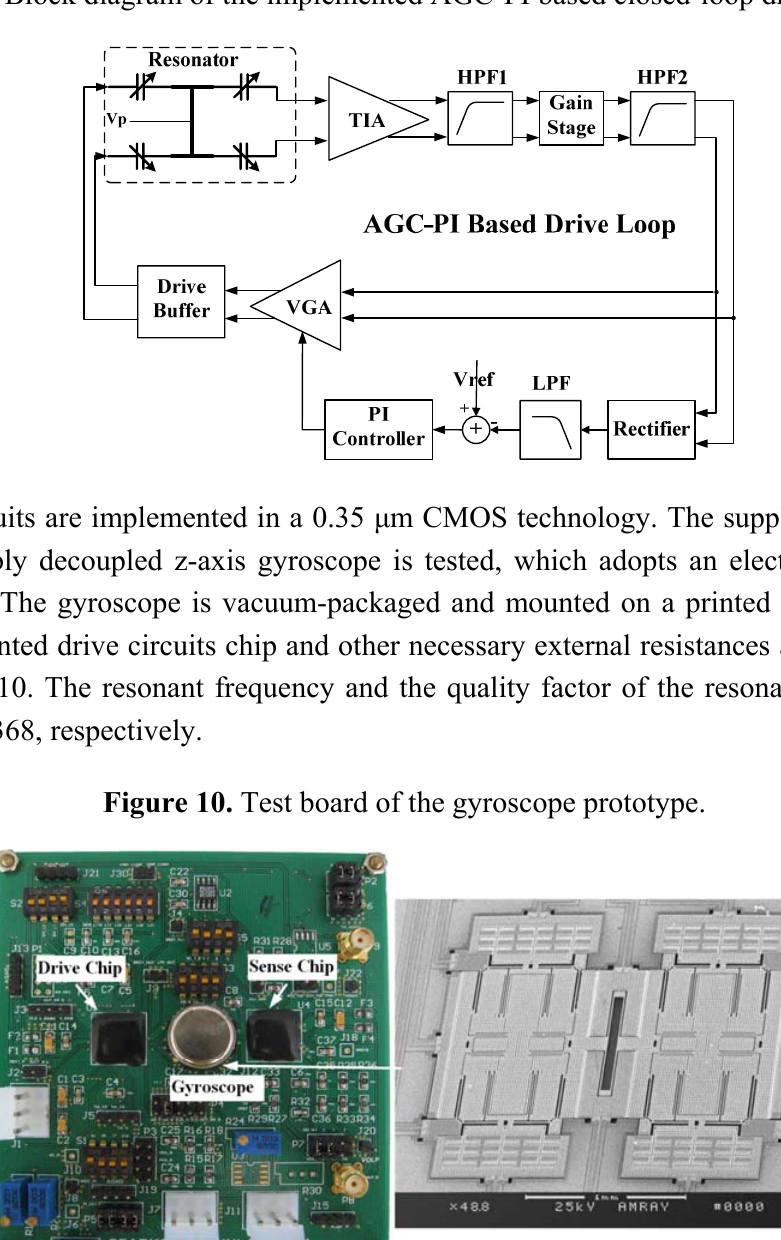
Figure 9. Block diagram of the implemented AGC-PI based closed-loop drive circuits.